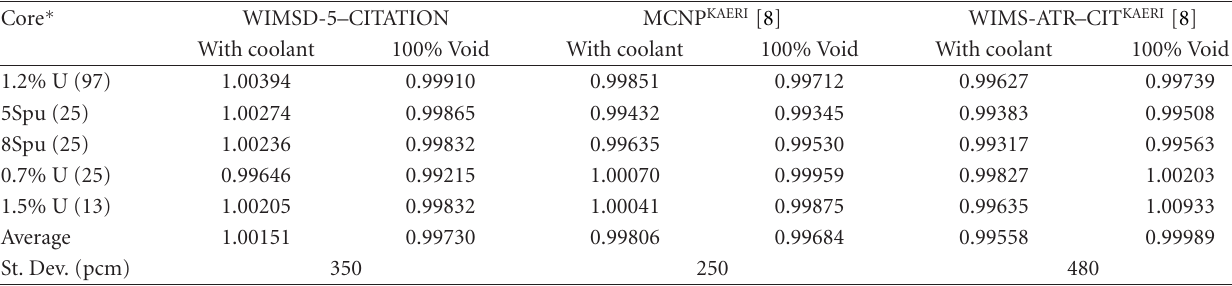
Table 1: Validation results on the e ff ective multiplication factor.